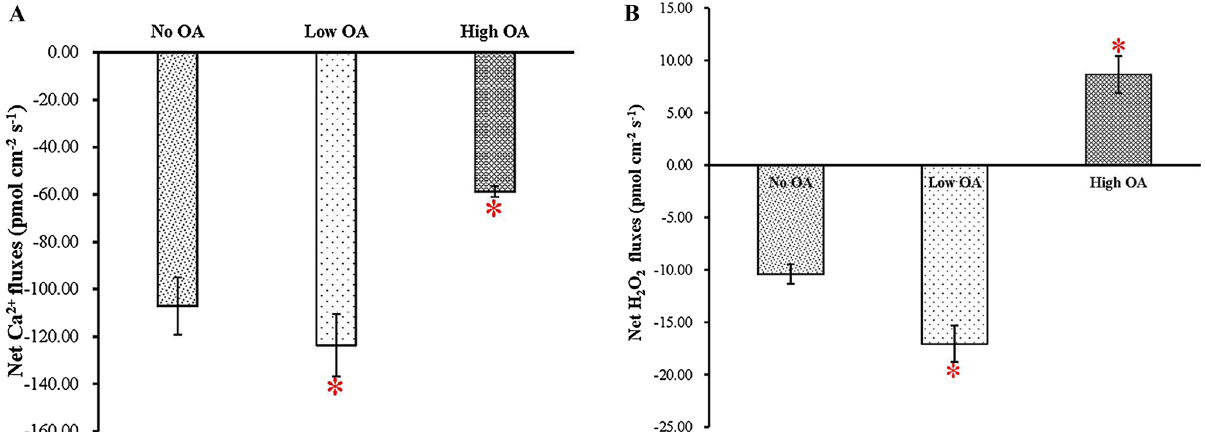
Figure 4. Real-time Ca 2+ and H 2 O 2 flux measurements of P. umbellatus mycelia affected by different concentrations of oxalic acid using NMT. ( A ) Real-time Ca 2+ influxes detection. ( B ) Real-time H 2 O 2 fluxes measurement. The values of the net Ca 2+ and H 2 O 2 fluxes are the means ± SD (n = 30), with * representing for P <